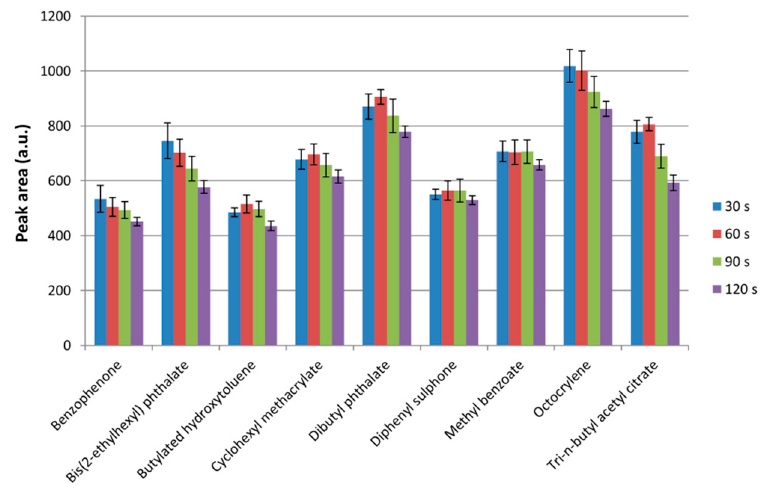
Figure 5. Study of the extraction solvent volume. Experimental conditions: extraction solvent, n ‐ hexane; extraction solvent volume, 5 mL; ionic strength, not adjusted. Bars in the graph represent the mean value of three replicates ± standard deviation.